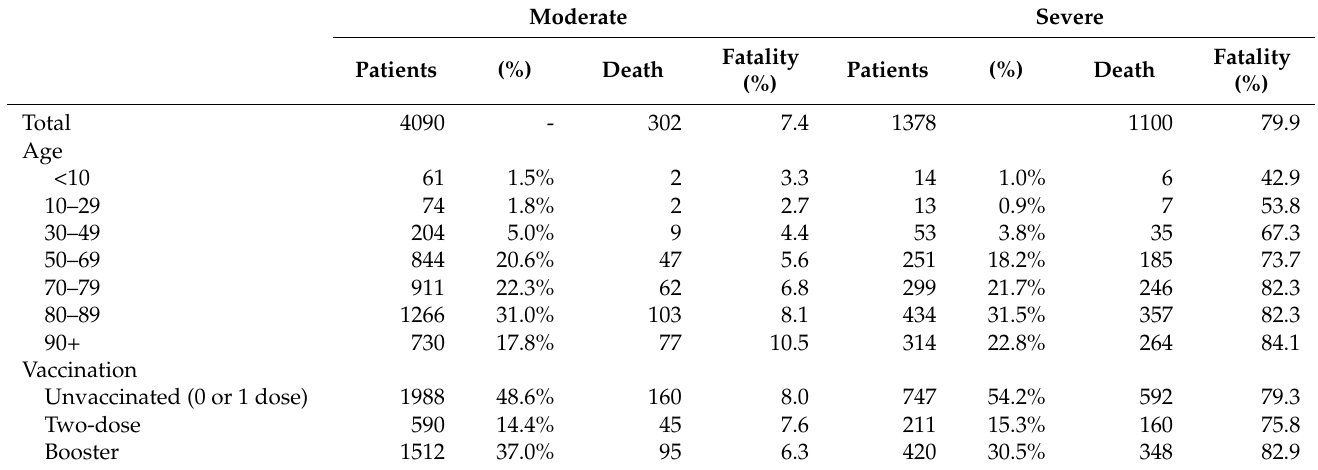
Table 1. Characteristics of hospitalized